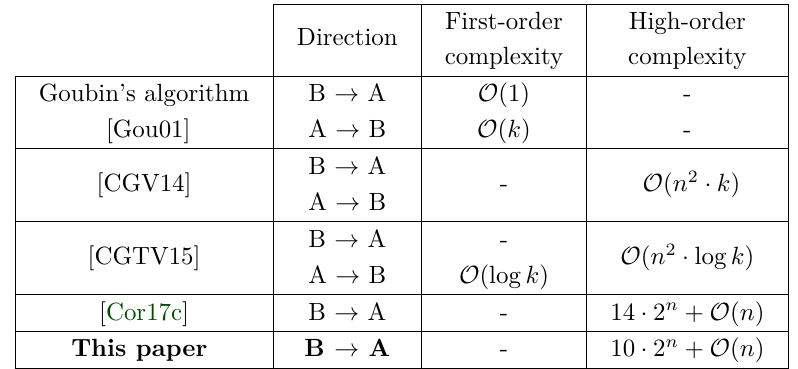
Table 1: Complexities of Boolean to arithmetic conversions in both directions, for first-order attacks, and for high-order attacks.